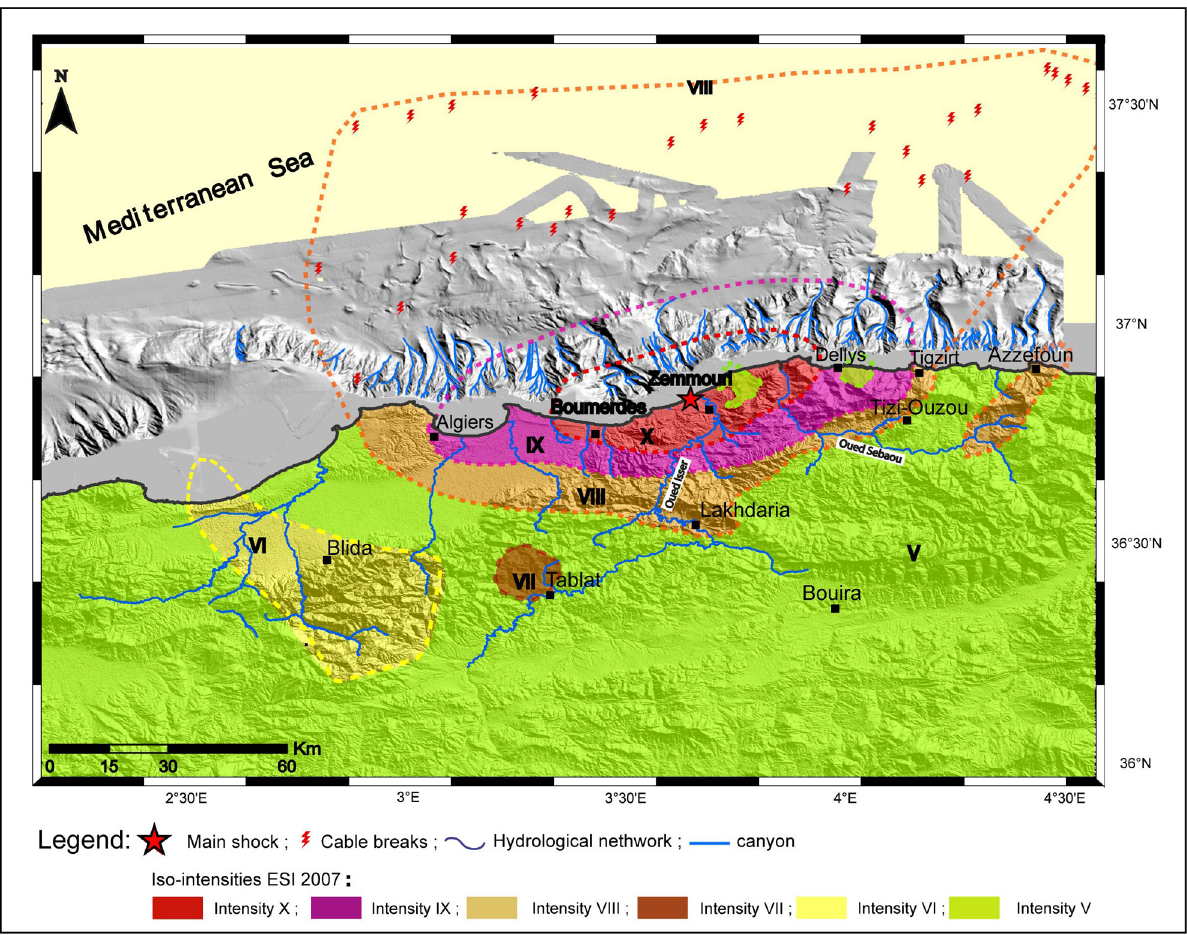
Figure 5. ESI local intensity map of the Boumerdès earthquake based on the ESI2007 scale. The colored dashed lines represent the supposed extension of the intensities